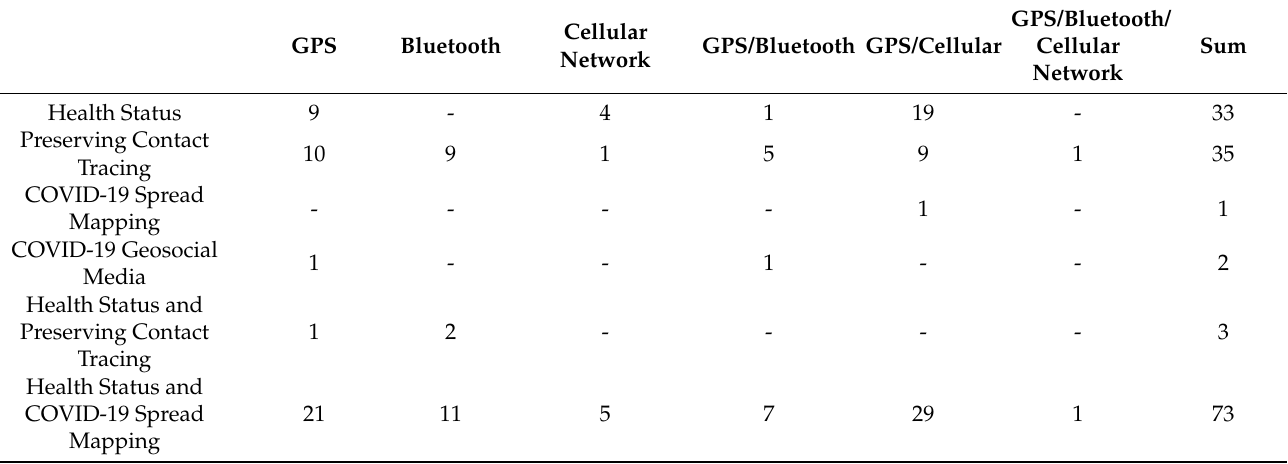
Table 2. Utilized